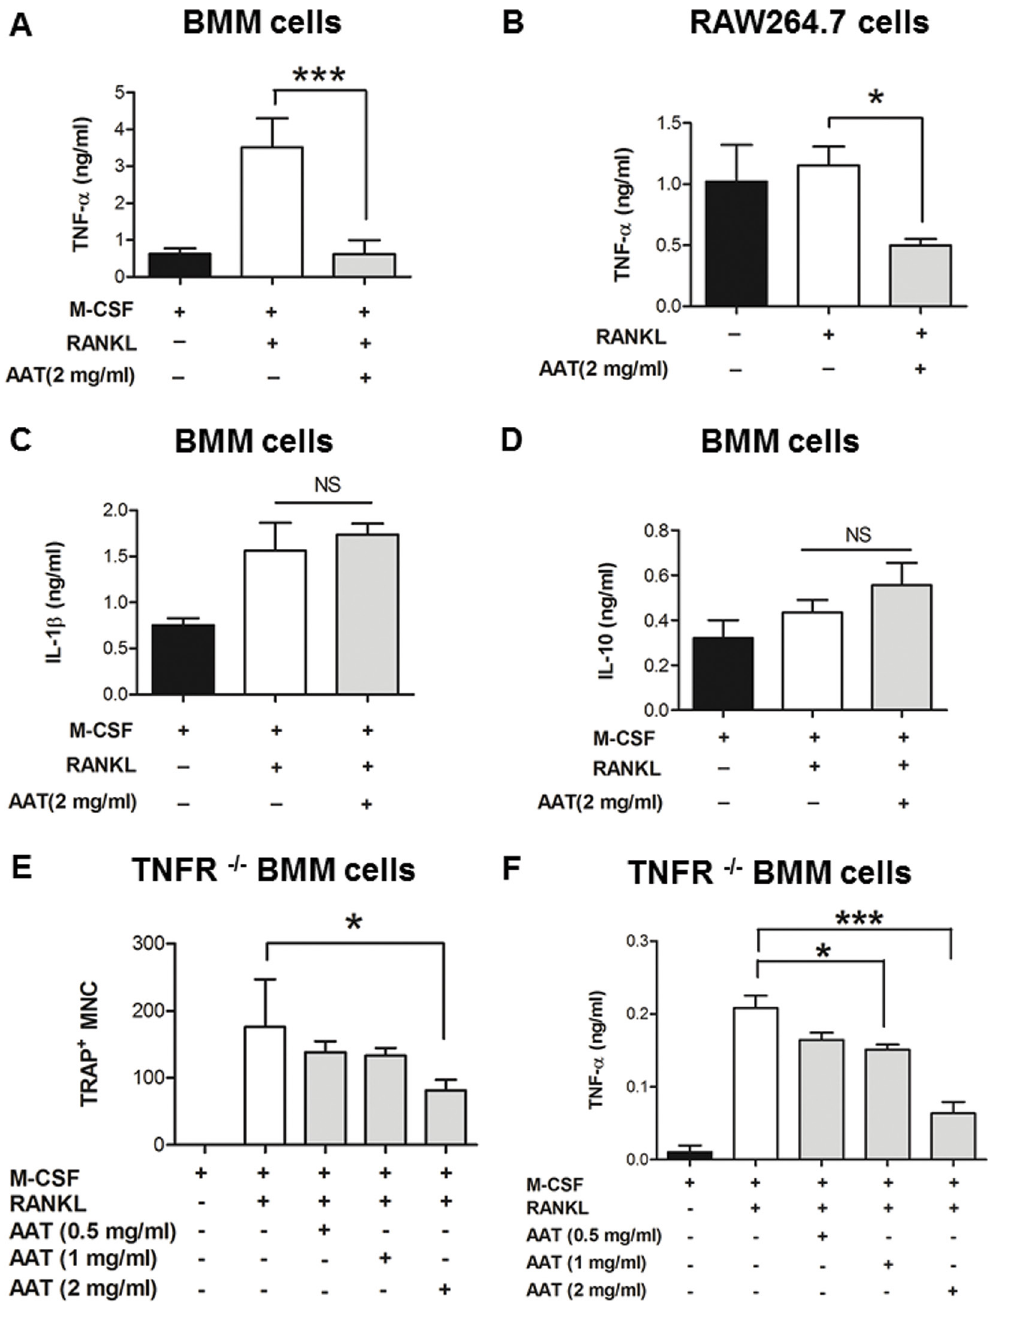
Figure 3. AAT inhibits RANKL-induced TNF- α production during osteoclast formation. (A) TNF- α concentrations in the culture medium of osteoclast cells derived from BMM cells. Here, AAT (2 mg/mL) was added from d 4–7 according to Exp-2 (which is diagrammatically mentioned in Figure 2A). (B) TNF- α concentrations in the culture medium of osteoclast cells derived from RAW267.4 cells. Here, AAT (2 mg/mL) was added during RANKL-induced osteoclast formation (d 0–6). (C–D) The concentrations of IL-1 β and IL-10 in BMM cell– derived osteoclast culture medium (n = 6). (E) TRAP + MNCs (cell number/well of 96-well cell culture plate) derived from BMM cells of TNF- α receptor knockout mice (TNFR1 -/- and TNFR2 -/- ). Here, AAT was added from d 4–7 according to Exp-2 during osteoclast generation. (F) The concentration of TNF- α in the culture medium of osteoclast cells derived from TNF- α receptor knockout mouse BMM cells accord- ing to Exp-2. Values are means ± SEM of at least triplicate samples. Data were analyzed using one-way analysis of variance followed by Dunnett’s multiple comparison test. * P < 0.05, *** P < 0.0001; NS =